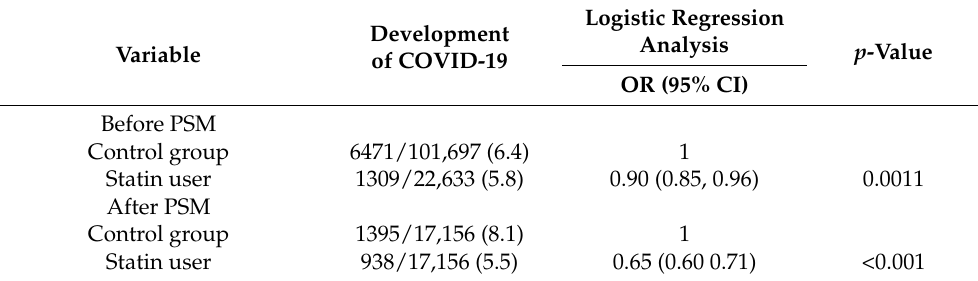
Table 2. Development of COVID-19 before and after PSM.